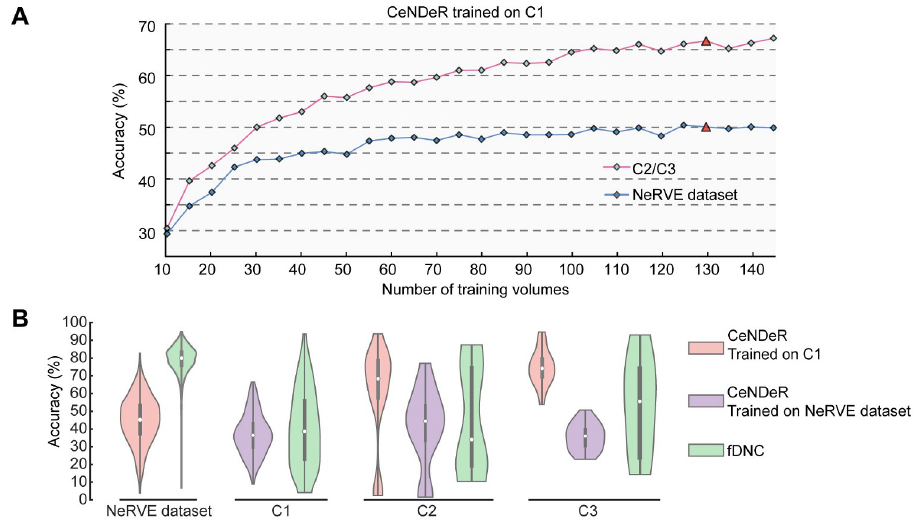
Fig 9. Performance of tracking neurons in a different animal with a pretrained model. (A) Tracking accuracy of C2/C3 and NeRVE dataset when CeNDeR was trained on C1 with different number of volumes. (B) Violin plot shows the distribution of tracking accuracy across animals. Pink colors: NeRVE dataset, C2 and C3 inferred by the CeNDeR method when CeNDeR was trained on 130 volumes from C1; purple colors: C1, C2 and C3 were inferred by the CeNDeR method when CeNDeR was trained on 130 volumes from NeRVE dataset; green colors: C1, C2, C3 and NeRVE dataset inferred by the fDNC method. Box plot inside each violin shows 25 and 75 percentiles of the distribution and the circle indicates the